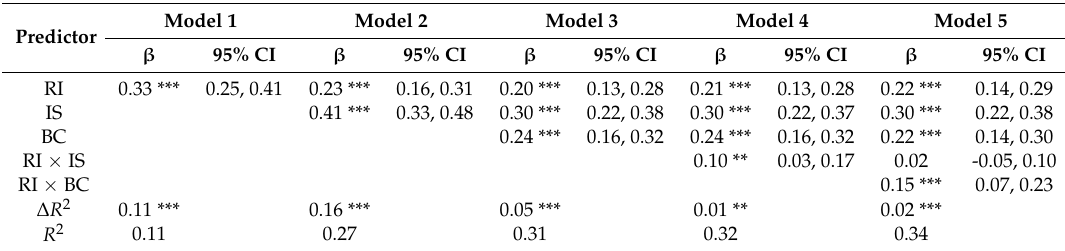
Table 2. Hierarchical OLS regression of recycling